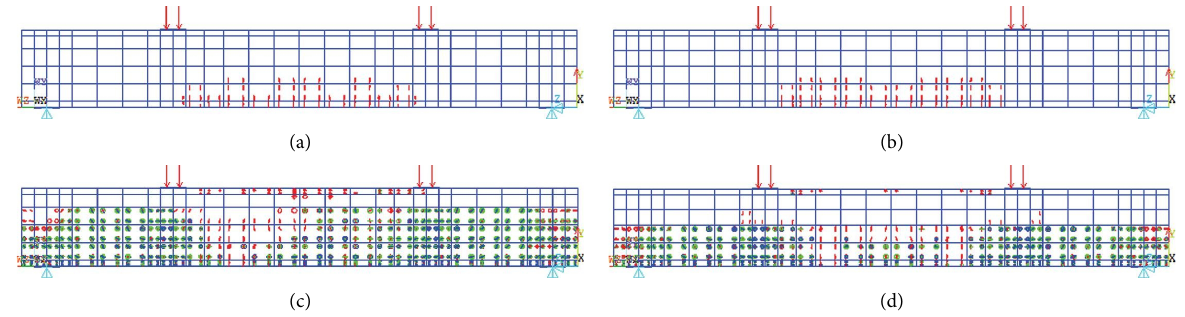
Figure 23: When the thickness of the steel fber layer changed, the beams immediately began to crack and were damaged: (a) cracks begin to appear in the beam ( P crack � 8 kN), H � 7 cm; (b) cracks begin to appear in the beam ( P crack � 8kN), H � 14cm; (c) beam beginning to show signs of damage ( Pmax � 125kN), H � 7cm; (d) beam beginning to show signs of damage ( P max � 128kN), H � 14cm.